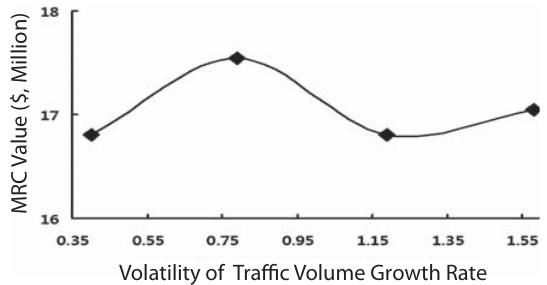
Figure 4. Sensitivity of the MRC value to